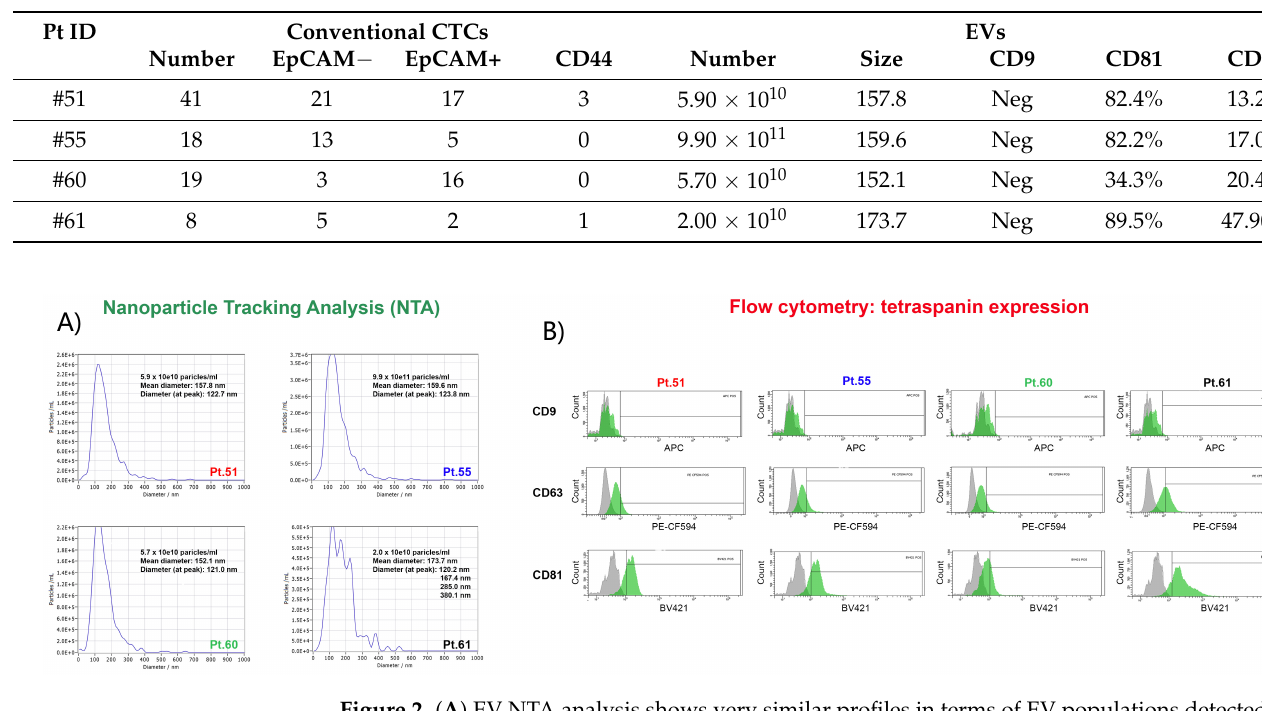
Figure 2. ( A ) EV NTA analysis shows very similar profiles in terms of EV populations detected in all patient samples but reveals a very peculiar nanoparticle distribution for Pt# 61, which may deserve further investigation. ( B ) Expression of typical EV markers CD9, CD63, and CD81 evaluated by flow cytometry on a BD FACS Aria. ( Upper panel ) The expression of CD9 was almost absent in EVs consistently in all four patients; ( middle panel ) CD63 was detected in a comparable percentage in Pt#51, Pt#55, and Pt#60, while for Pt#61, it shows an almost double expression; ( lower panel ) EVs presented a similar expression of CD81 in Pt#51, Pt#55, and Pt#61 samples, while in Pt#60, it presented a lower expression. Some like 2.0E+5 mean 2.0 × 10 5